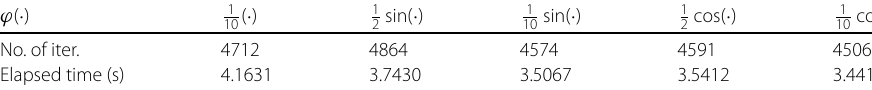
Table 3 Numerical results of ϕ ( · )